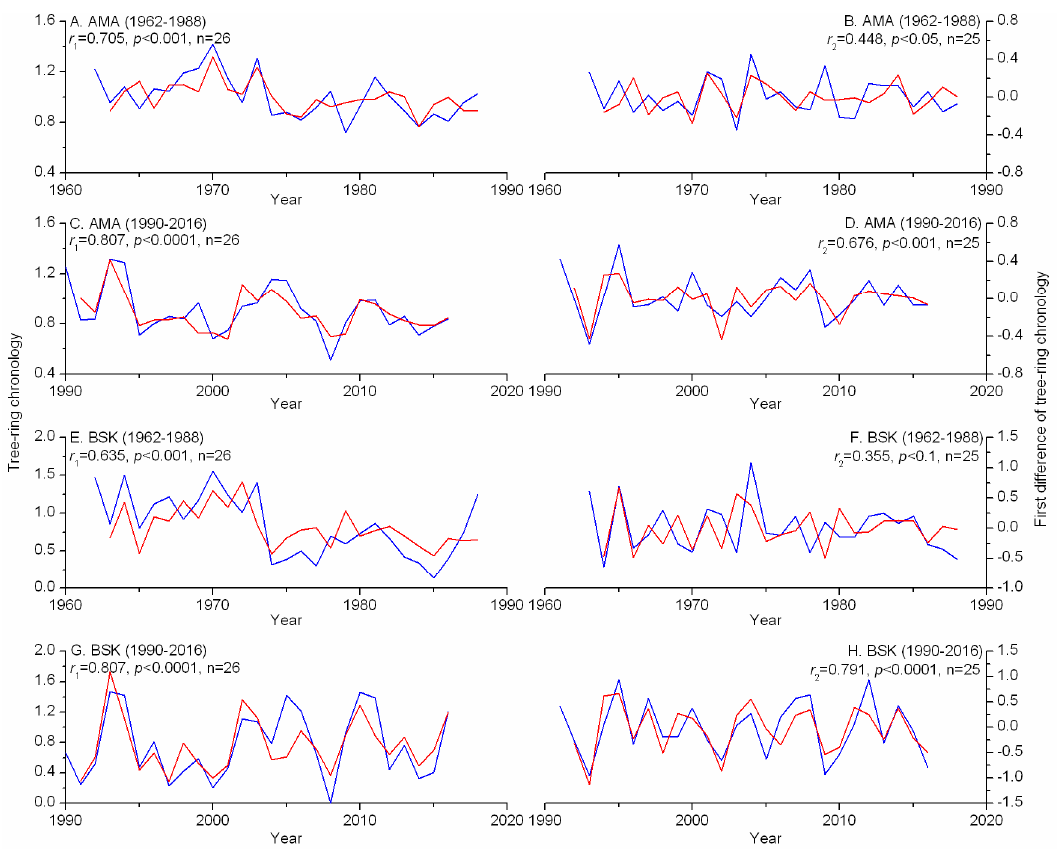
Figure 6. Comparison between simulated (red line) and calibrated (blue line) tree-ring chronologies in the original ( A , C , E , G ) and first difference ( B , D , F , H ) domains for two different periods 1962–1988 and 1990–2016.